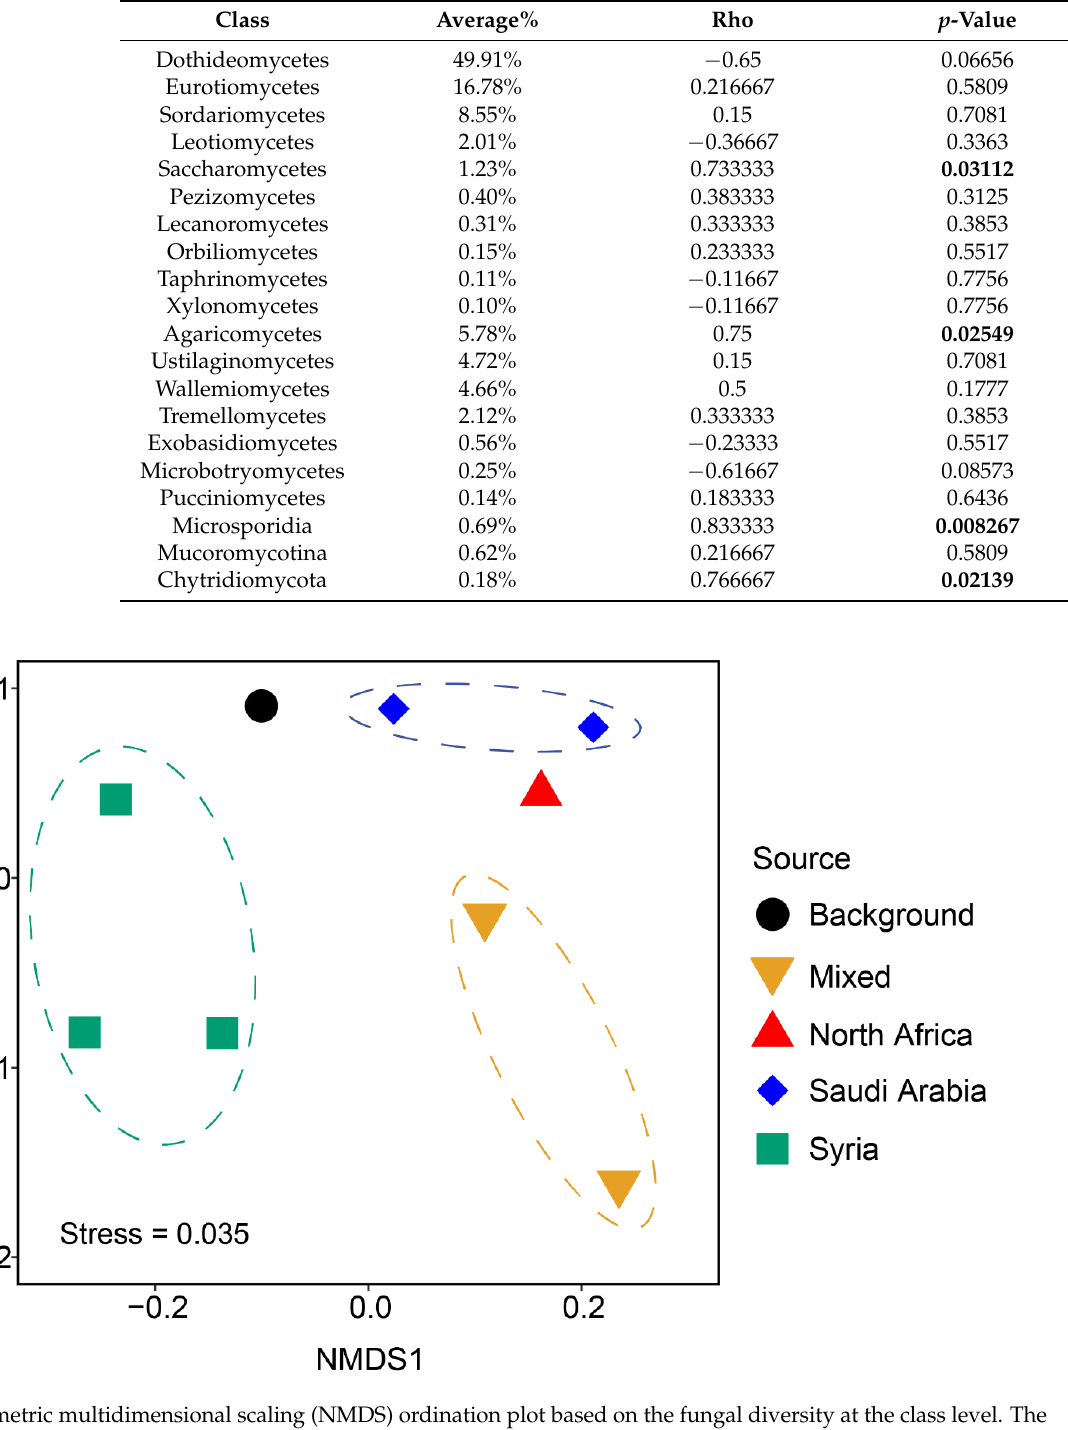
Table 1. The Spearman’s rank-order correlation coefficient (rho) between PM10 and the relative abundance of the 20 most abundant fungal classes (shown as average%). p -values smaller than 0.05 are highlighted with bold fonts.